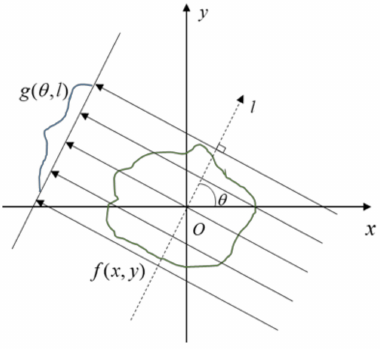
Figure 4. Parallel beam geometry of